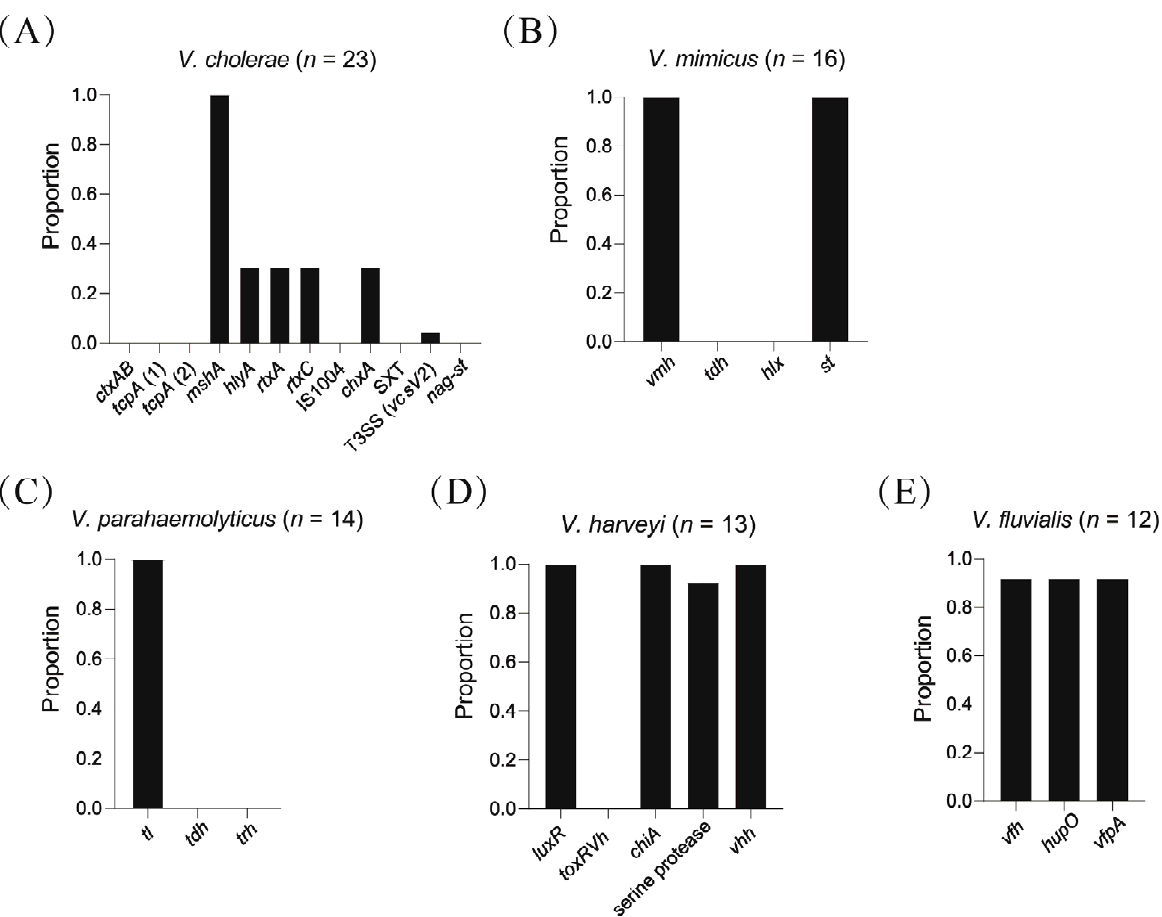
Figure 2. Distribution of virulence genes among five common pathogenic species. The bars represent the proportions of virulence genes in each species ( A – E ).